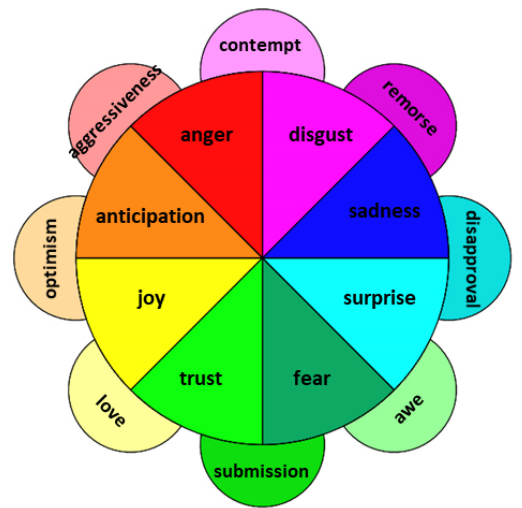
Figure 1. Wheel of Figure 1 . Wheel of emotions.